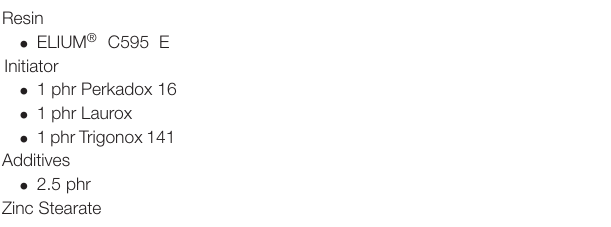
FIGURE 2 | Schematic representation of a standard Pultrusion process. TABLE 2 | Typical formulation for ELIUM ® pultrusion.